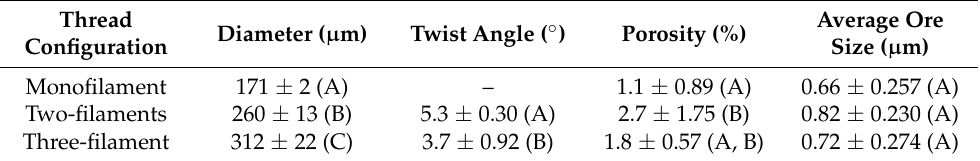
Figure 3. SEM micrographs of the chitosan threads longitudinal and cross-section: ( a1–a3 ) Monofilament configuration; ( b1–b3 ) two-filament configuration; and ( c1–c3 ) three-filament configuration. Table 1. Parameters of the mono- and multifilament chitosan threads obtained from SEM analysis (mean ± standard